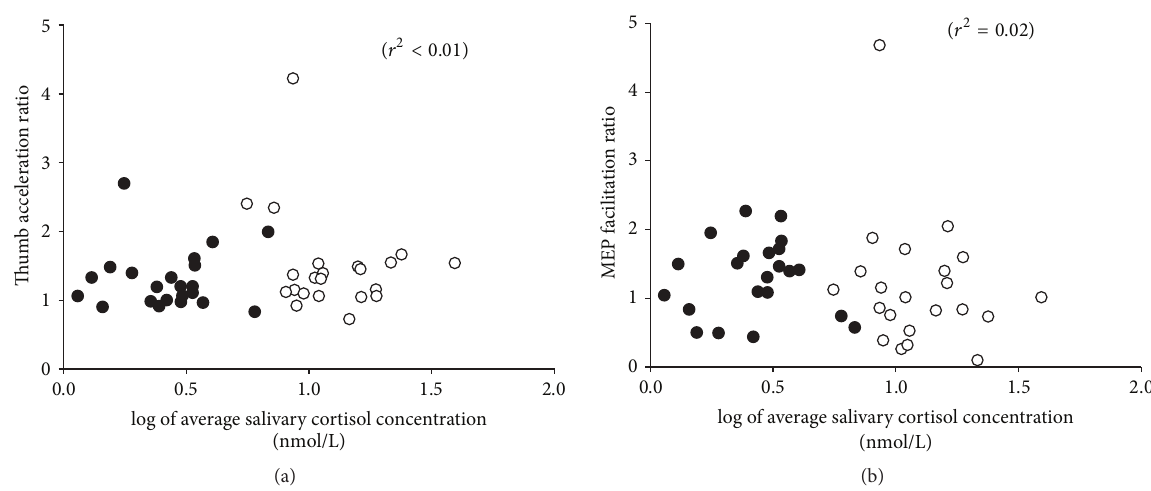
Figure6:Relationshipbetweenmotorperformance(a),corticalexcitability(b),andsalivarycortisolconcentration.Linearregressionanalysis revealed a nonsignificant ( 𝑟 2 < 0.01) relationship between acceleration ratio (max. acceleration post-MT/max. acceleration pre-MT) and the log of average salivary cortisol concentration (a). Linear regression analysis revealed a nonsignificant ( 𝑟 2 = 0.02) relationship between MEP facilitation ratio (MEP amplitude post-MT/MEP amplitude pre-MT) and the log of average salivary cortisol concentration (b). Data include morning (unfilled circles) and evening (filled circles)